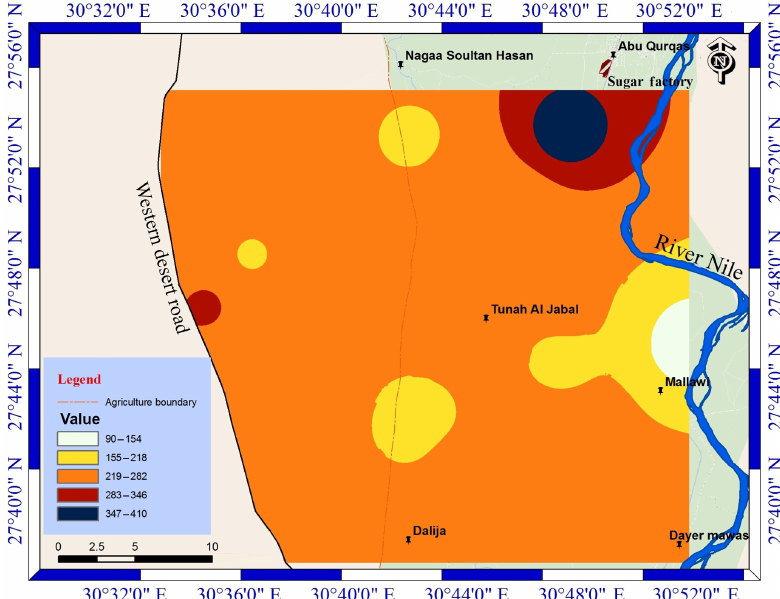
Figure 4. Spatial distribution map of Pb in the studied groundwater samples.